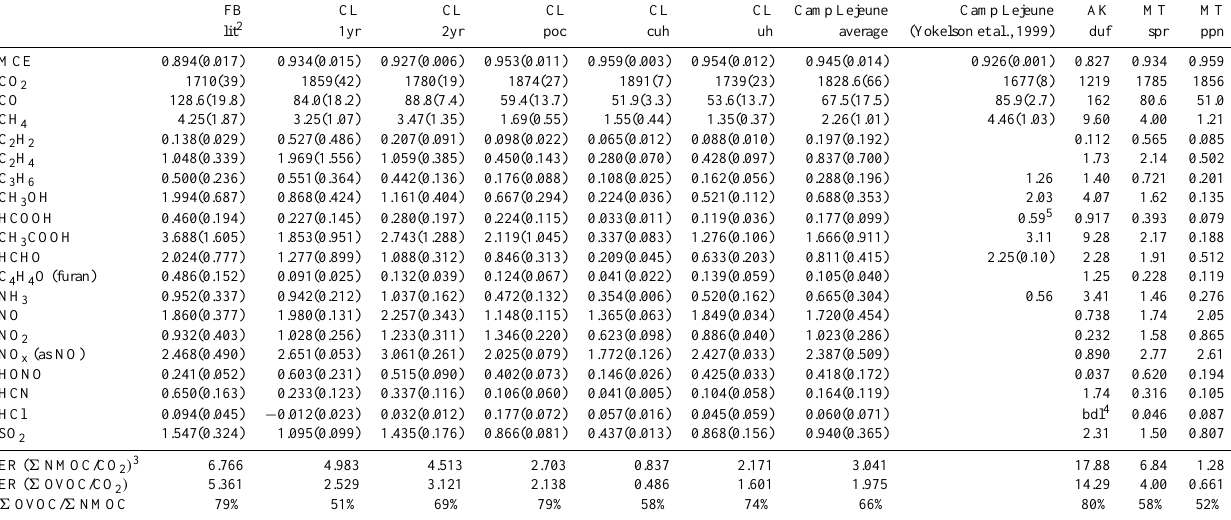
1 Value in brackets corresponds to (1 σ) standard deviation. 2 See Table 1 for fuel codes. 3 NMOC and OVOC data includes only those species measured by OP-FTIR and are given as molar emission ratios (mmol mol − 1 ) . 4 bdl – below detection limit. 5